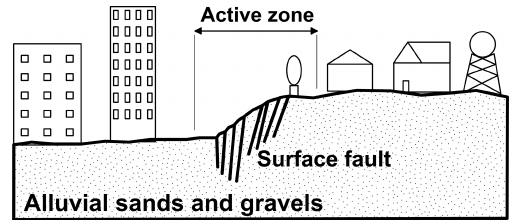
Figure 1. Scheme showing the active zone, which is the strip of me- chanical disturbing caused by the main terrain discontinuity, where buildings and infrastructure can suffer damaged by differential sub-